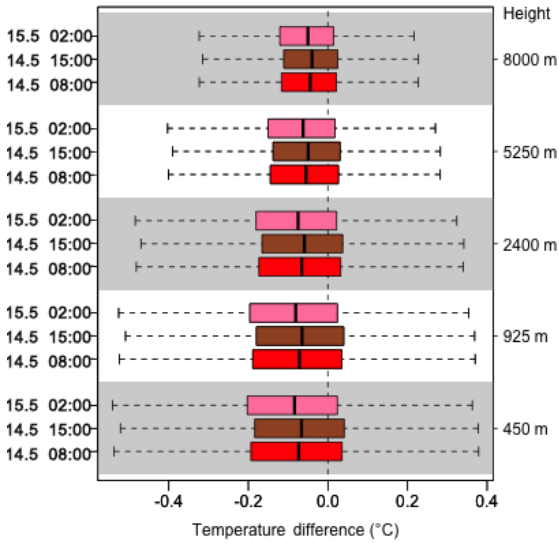
Figure 7. Temperature differences between HR and DEFAULT in domain 3.